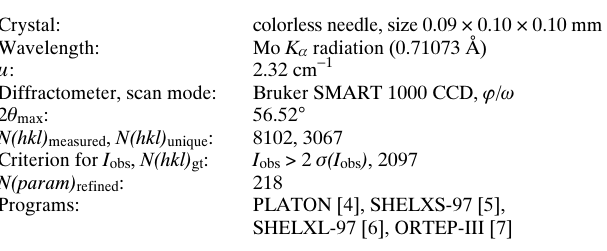
Table 1. Data collection and handling.